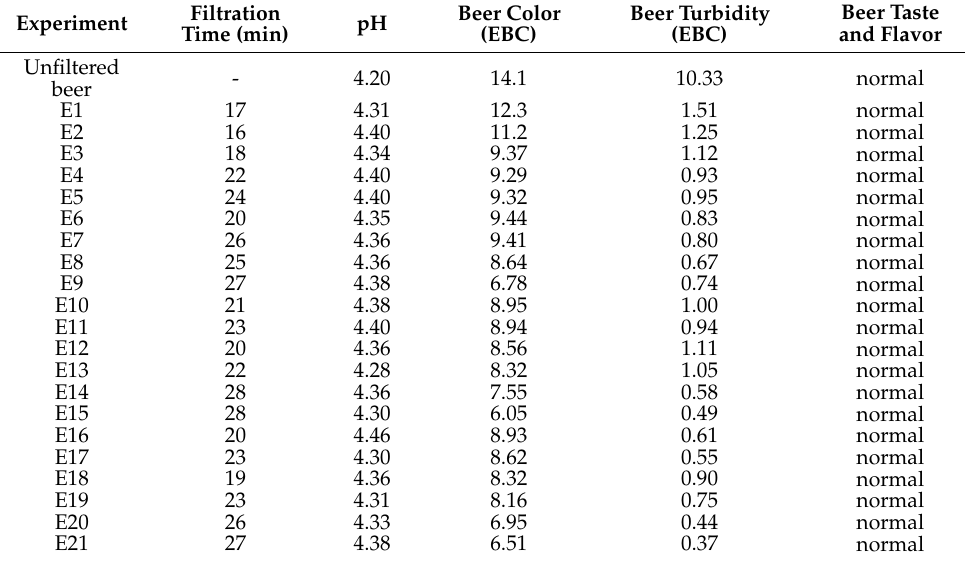
Table 4. Filtration time and the main characteristics of unfiltered and filtered beer samples from laboratory